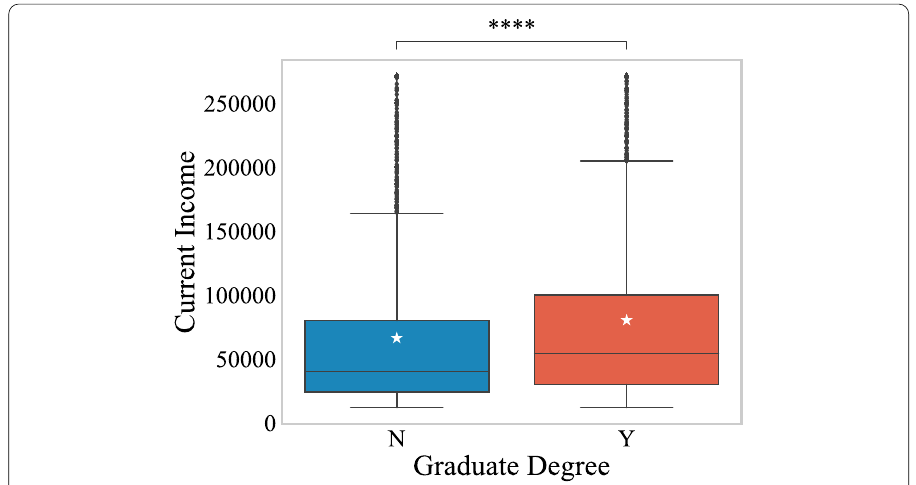
Fig. 8 First Income and Current Income boxplot based on Graduate Degree variable distribution count